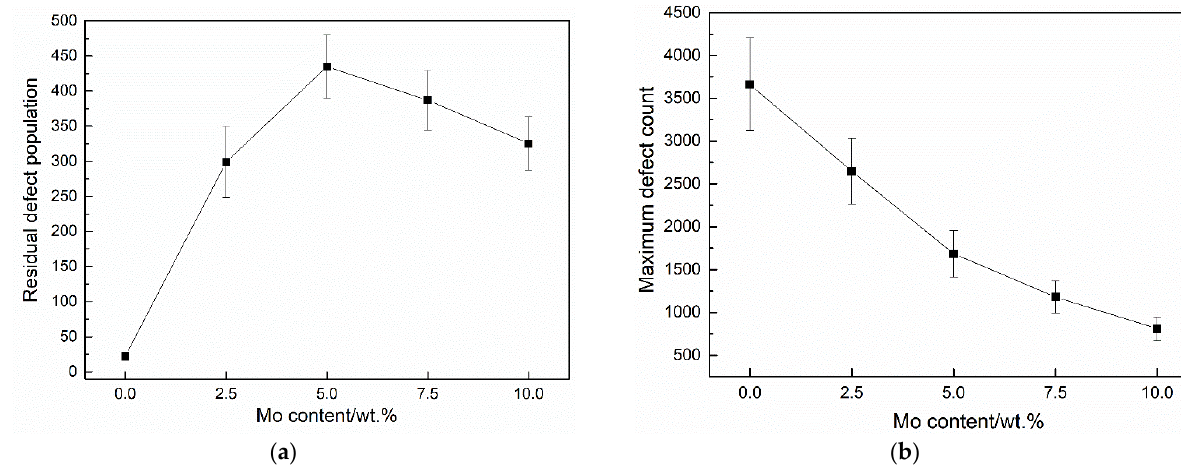
Figure 6. Statistical results of ( a ) residual defect population and ( b ) peak values of defect population during cascade simulations with different Mo contents.